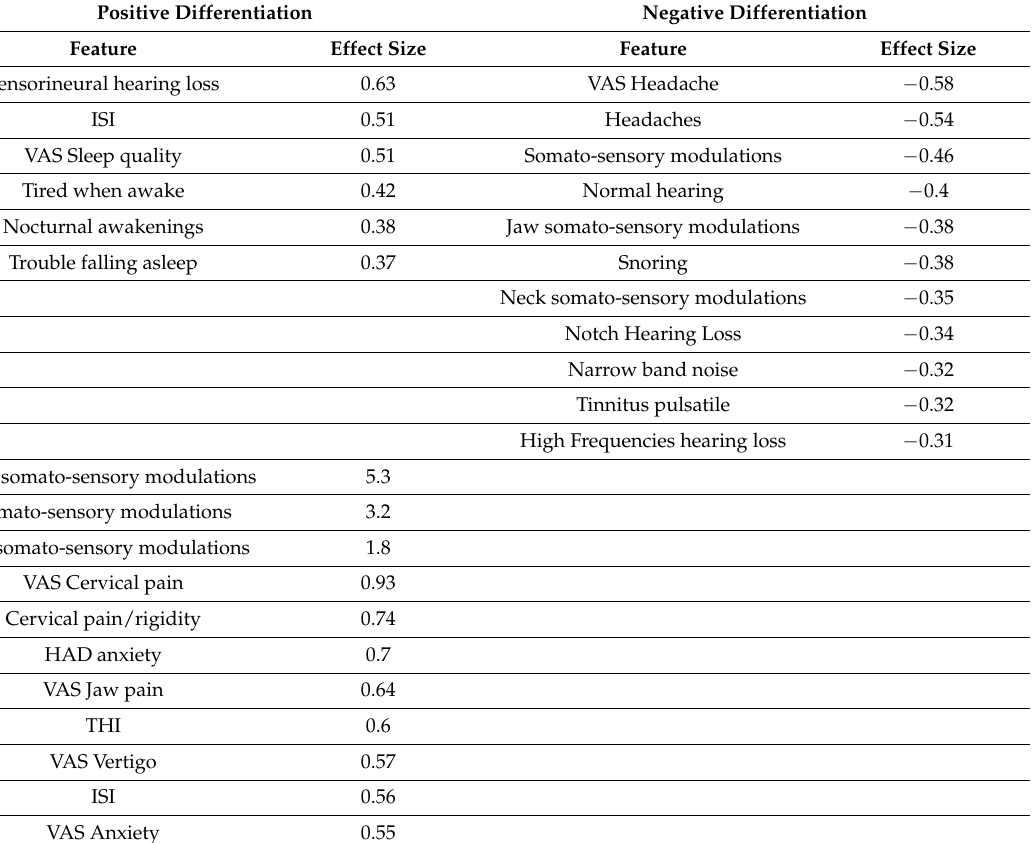
Table 7. Cont. Individual Clusters Characteristics of the Finally Selcted